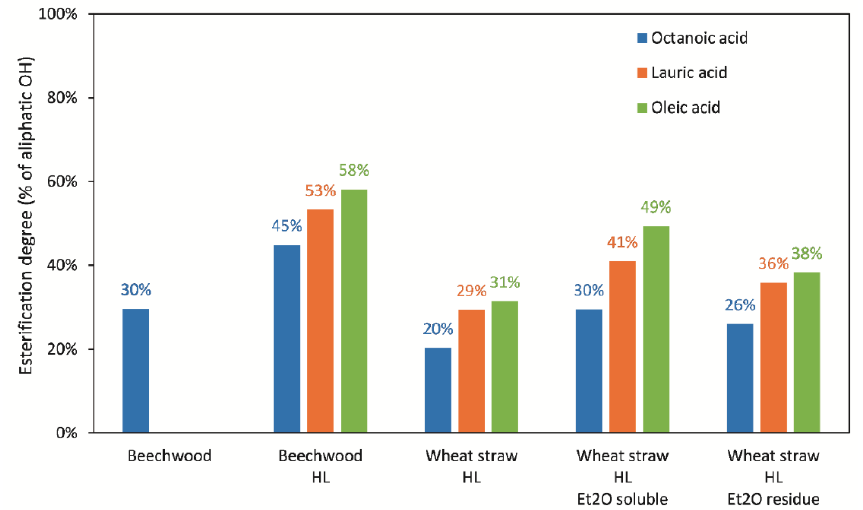
Figure 6. Esterification degree of the different lignin fractions with various fatty acids. The reactions were performed using 1 molar equivalent of fatty acid with respect to the aliphatic OH groups in lignin, using acetone as a solvent, and catalyzed by lipase at 20 °C for 72 h. The amount of remaining free aliphatic OH groups after esterification was quantified by 31 P-NMR in every reaction as mmol/g sample (including the residual fatty acid) and it was converted to mmol/g of lignin by multiplying the value with the mass % of lignin in the sample. The corrected value was then compared to the aliphatic OH content (mmol/g lignin) in the original lignin fractions in order to calculate the esterification degree.